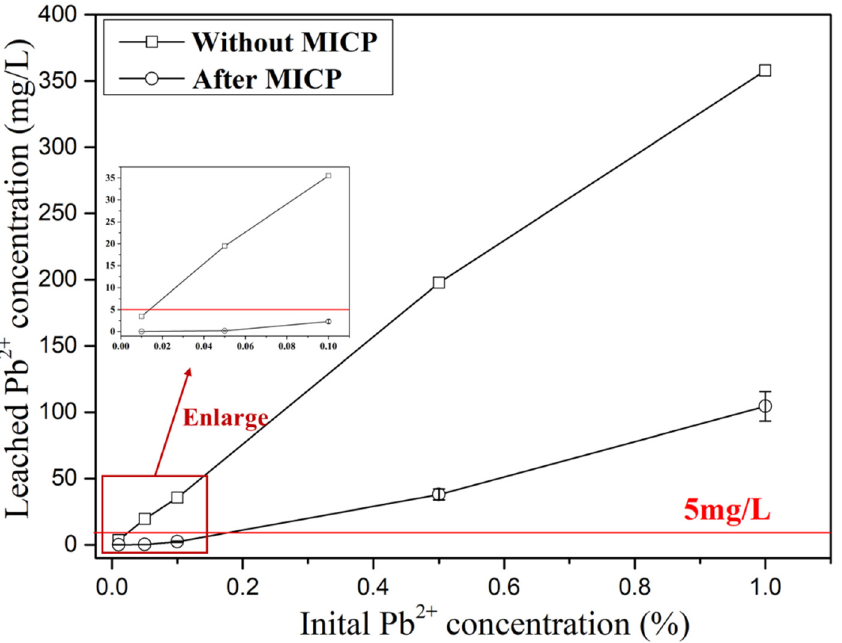
Figure 7. Leachate Pb 2+ concentrations from silty soil samples with different initial Pb content cured by the microbial-induced carbonate precipitation (MICP) process.